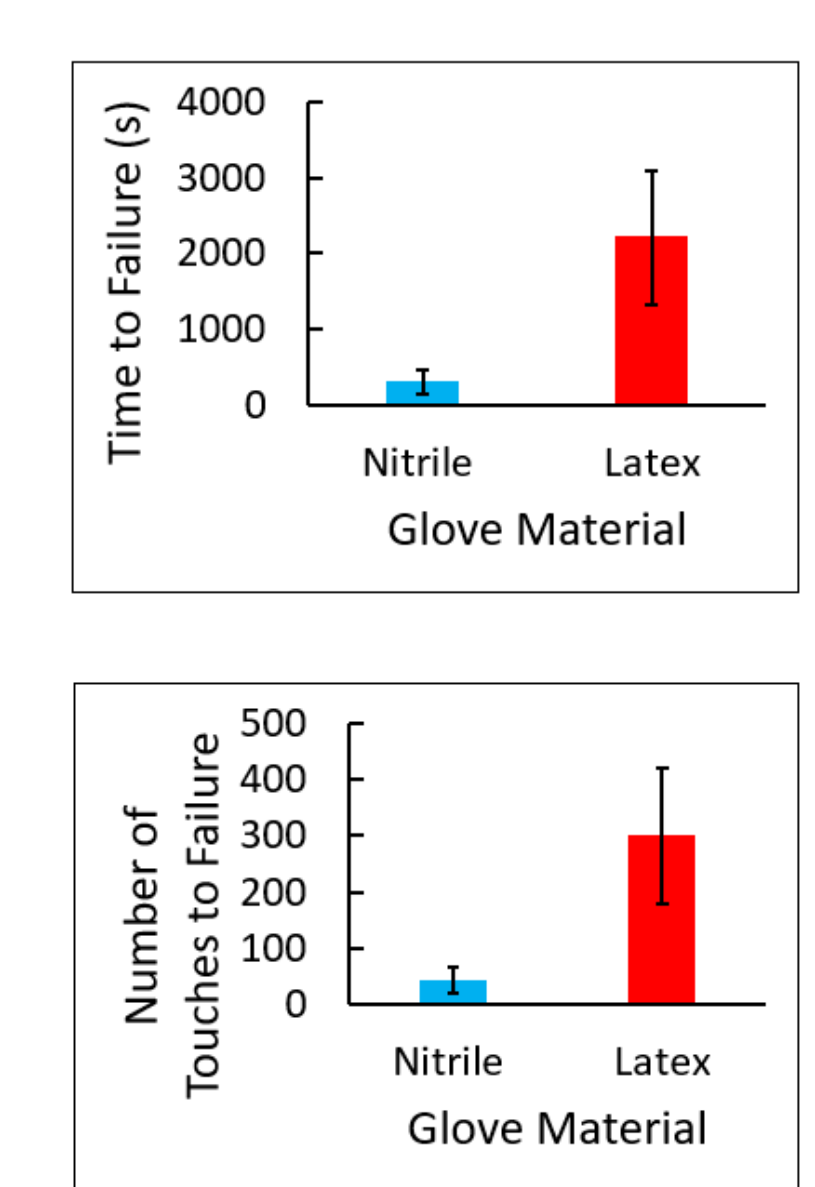
Figure 14. ( a ) Failure times in seconds for nitrile and latex examination gloves. The average failure time for nitrile gloves was 300 ± 164 s, and the average failure time for latex gloves was 2206 ± 888 s. Each value is the mean of 5 ± SD. ( b ) Number of sandpaper touches to failure for nitrile and latex examination gloves. The average number of touches for nitrile glove failure was 42 ± 23 touches, and the average number of touches for latex gloves was 300 ± 121. Each value is the mean of 5 ±